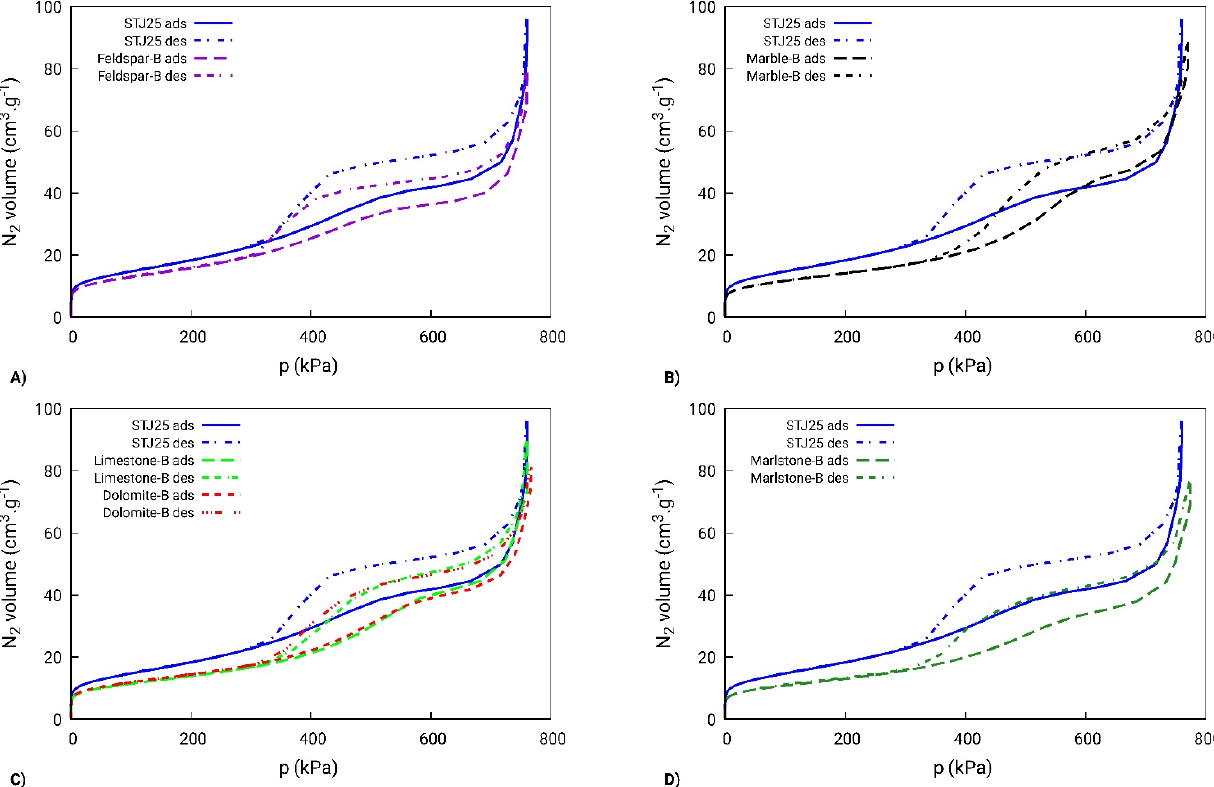
Figure 3. Nitrogen adsorption/desorption isotherms, the amount of N 2 in pores in pressure steps; the four types and courses of the hysteresis loops.